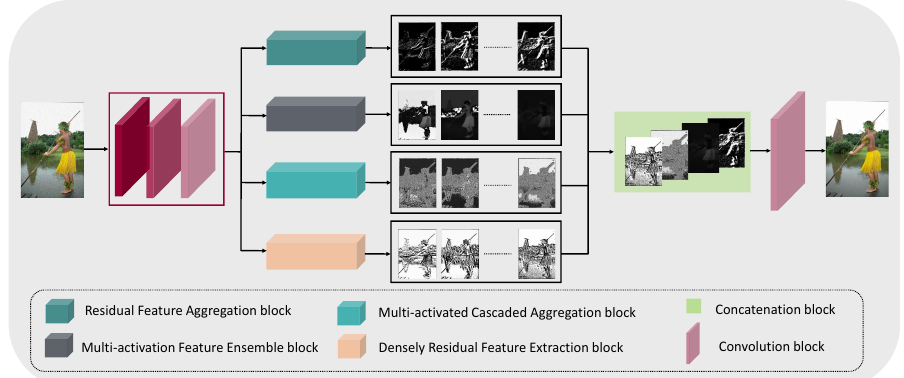
Figure 3. In the above figure, we present the overall diagram of the proposed architecture for image denoising. Our pipeline first extracts the initial feature using consecutive convolution operation, followed by the four modules for feature refinements. These modules are standing upon the cus- tomized convolution and residual setup with supportive activation functions. After refinement, we concatenate all the refined feature maps into a single layer, followed by a final dilated convolution to make the